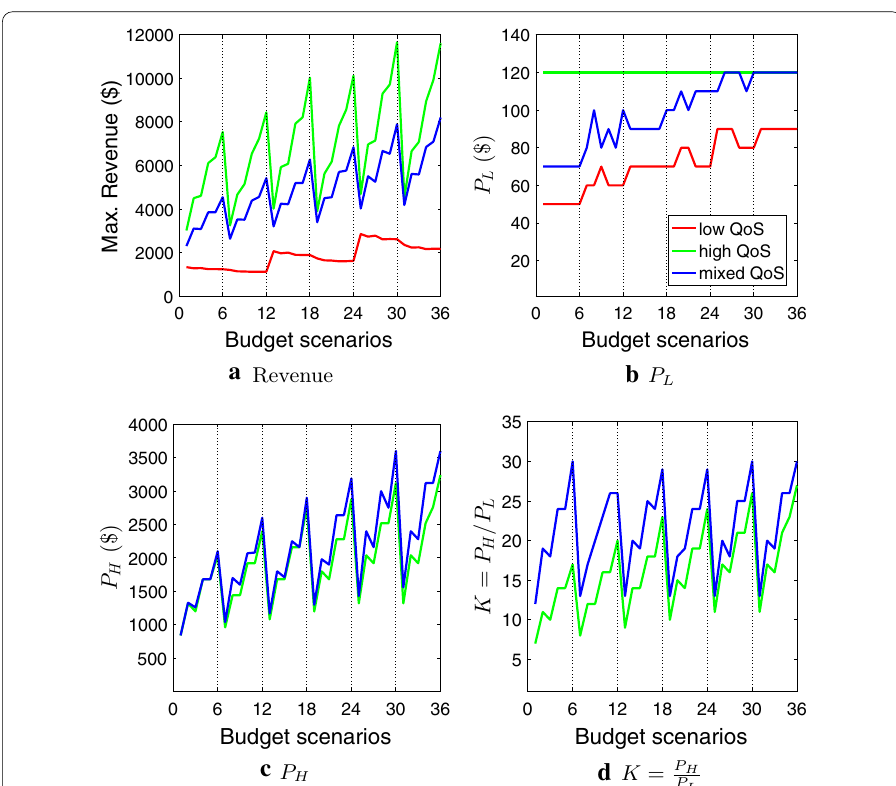
Fig. 6 Max. revenue and the corresponding values for P L and P H for the three QoS scenarios. Technical parameters: f = 3800 MHz, indoor. The choice of the QoS class is